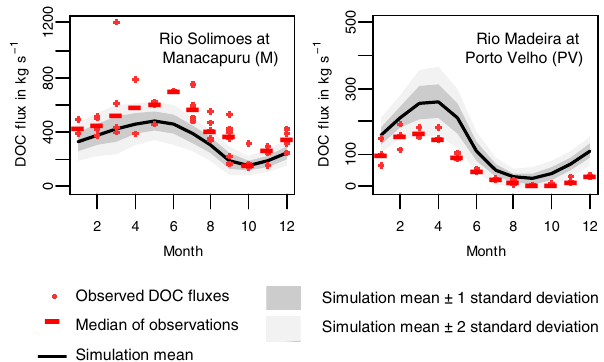
Figure 15. Seasonality in DOC fluxes in rivers at two sampling lo- cations with more than 10 samples: Rio Solimoes at Manacapuru (RMSE = 29.4%, NSE = 0.17) and Rio Madeira at Porto Velho (RMSE = 89%, NSE =− 0.06). Simulated data report the mean of simulated values per month over the simulation period 1980–2000, including standard deviations of monthly means over the same pe- riod. Observed data are from Moreira-Turcq et al. (2003), Cochon- neau et al. (2006) and Richey et al. (2008). For the observed data, we report median values (instead of the mean, which is more sensi- tive to single outliers).